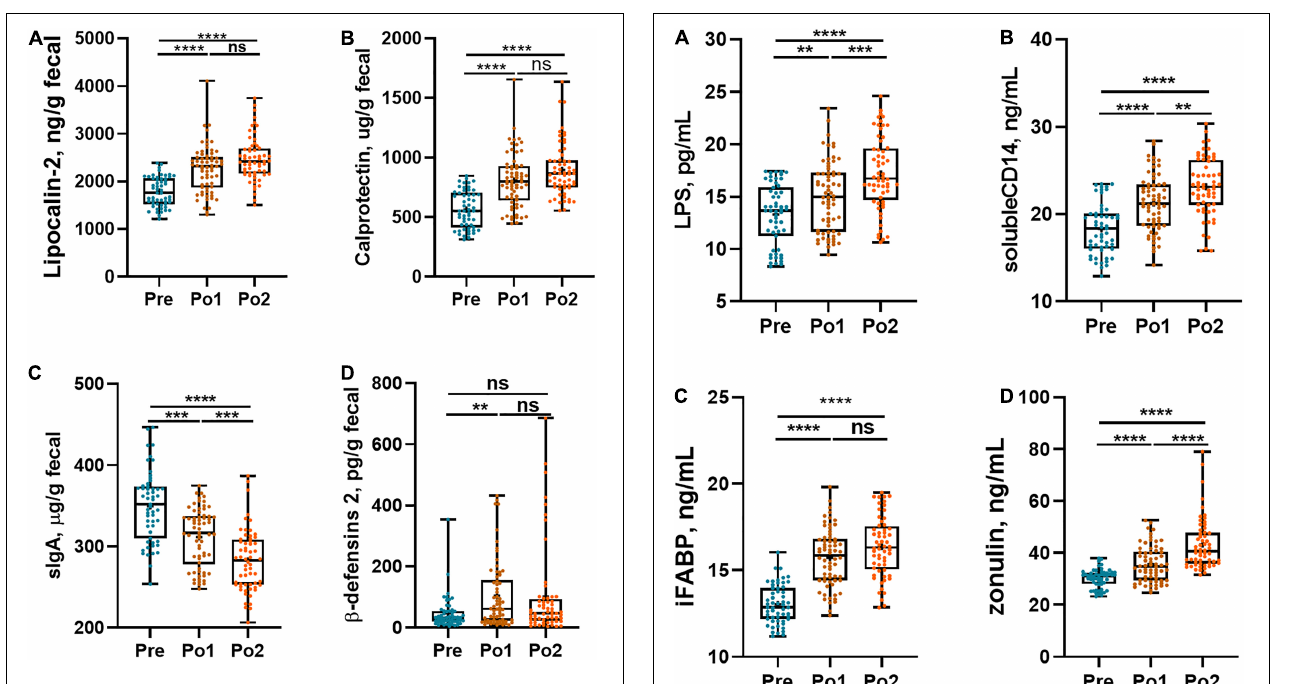
FIGURE 3 | Perioperative gut barrier biomarkers of cohorts. Plasma LPS (A) , sCD14 (B) , iFABP (C) , and zonulin (D) were assessed across time series. Statistical assessment was carried out with one-way analysis of variance or Kruskal–Wallis test for parametric or non-parametric data followed by post hoc test using Dunn’s multiple comparison test. P < 0.05 indicates statistical significance (* P < 0.05, ** P < 0.01, *** P < 0.001, and **** P < 0.0001), and ns means P > 0.05. Results are expressed as median and